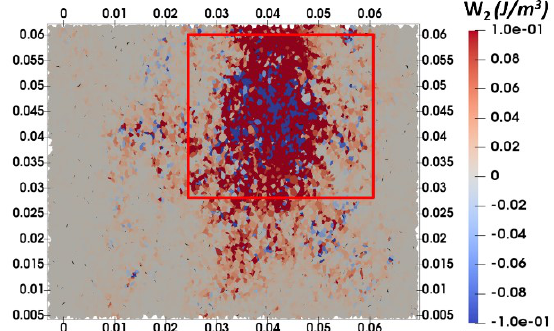
Fig. 5. Screenshot of the presented burst. The meso domains are colored in function of their internal second-order work. The box used for the delimitation of the burst is superimposed to the screenshot. We notice that the extension of the variations of the meso internal second order work is wider than the micro kinetic energy and highlight zones will be soon concerned by the burst of kinetic